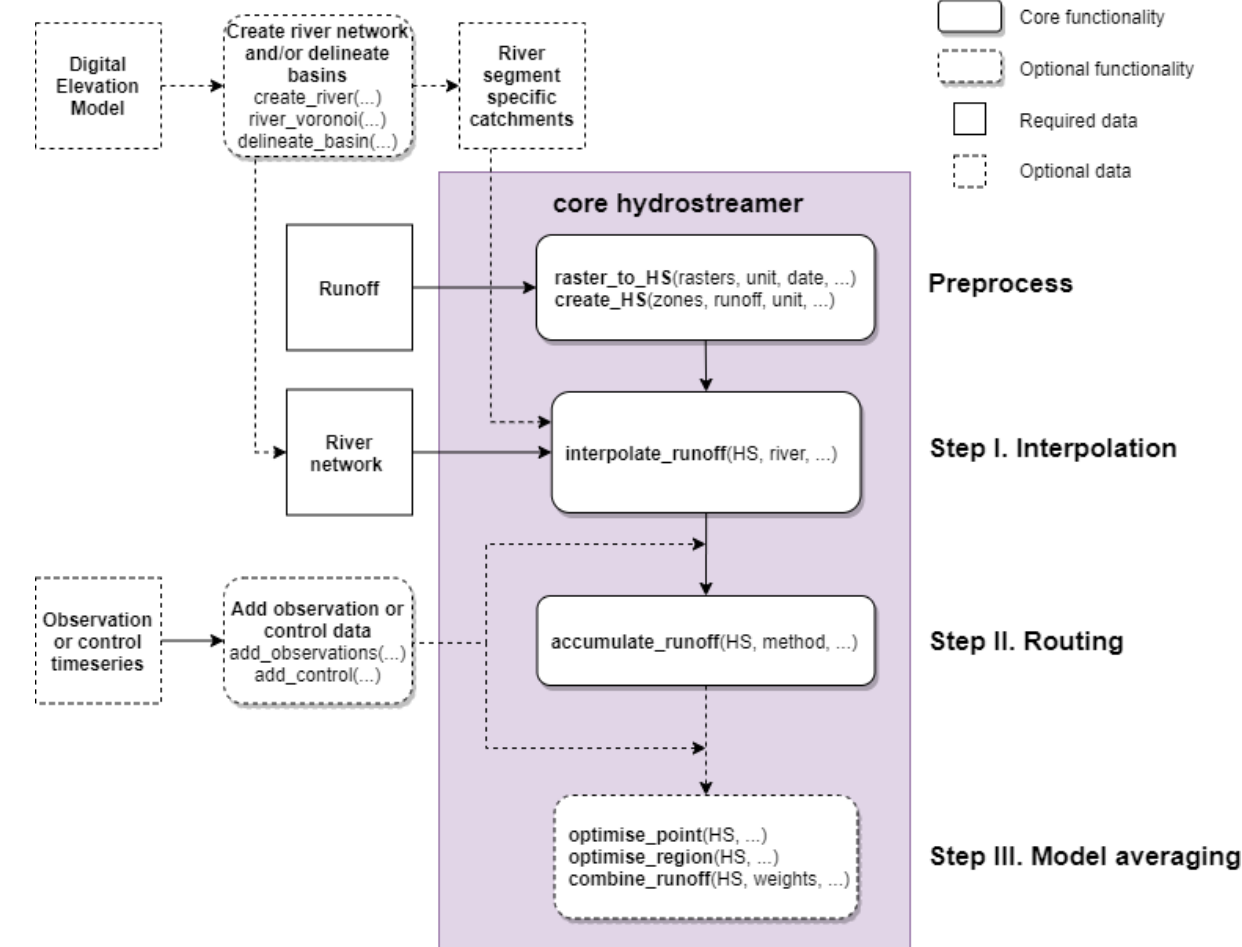
Fig. 1. The ellipsis marks optional function